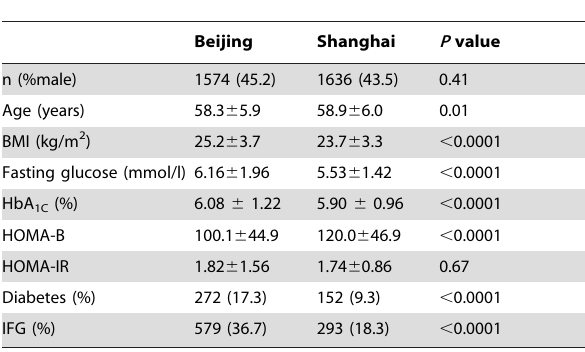
Table 1. Characteristics of the study population.